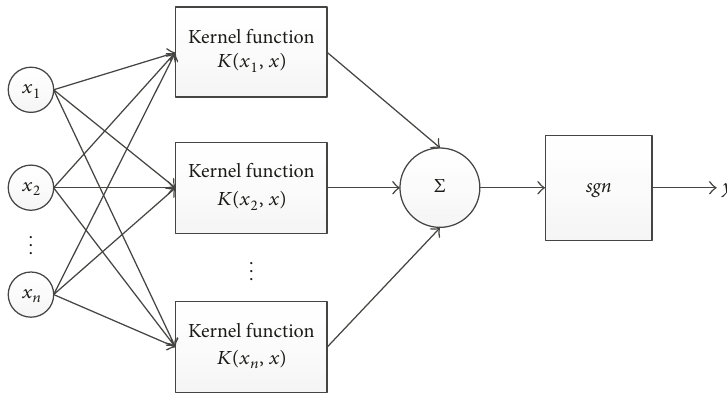
Figure 1: Schematic diagram of support vector